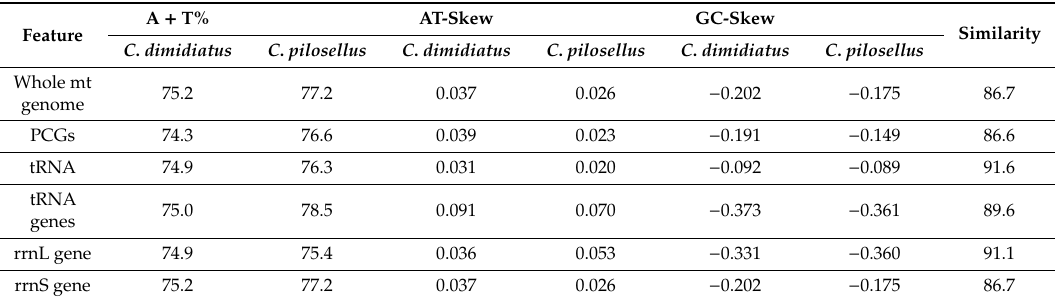
Table 2. Nucleotide composition and similarity of mitochondrial genomes of C . dimidiatus and C . pilosellus